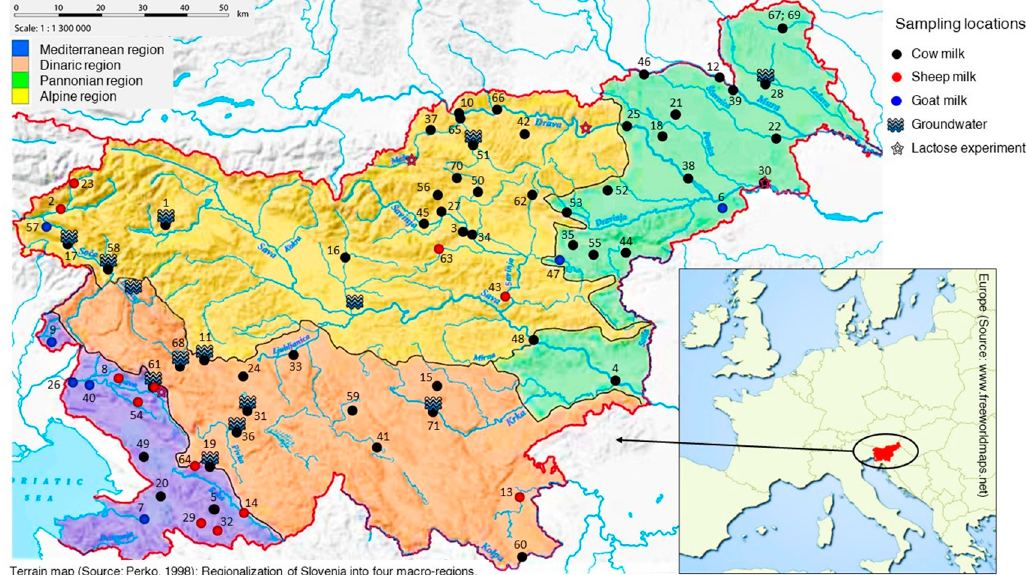
Figure 8. Macroregion division in Slovenia (after Perko, 1998) showing sampling locations of raw milk from di ff erent species covering geographical macro-regions (as indicated). The numbers correspond to the numbers of locations presented in Tables S1 and S2 (Supplement material). The locations used in experiments are also presented.